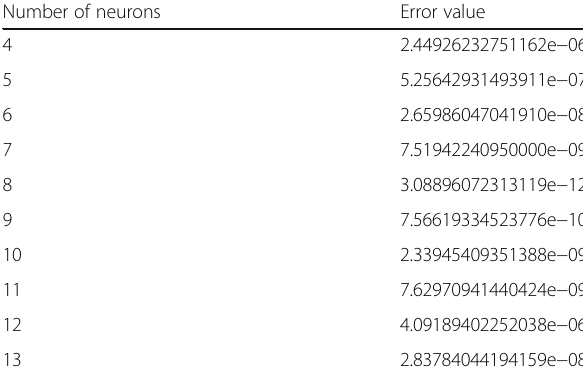
Table 2 The error values of each training Number of neurons Error value